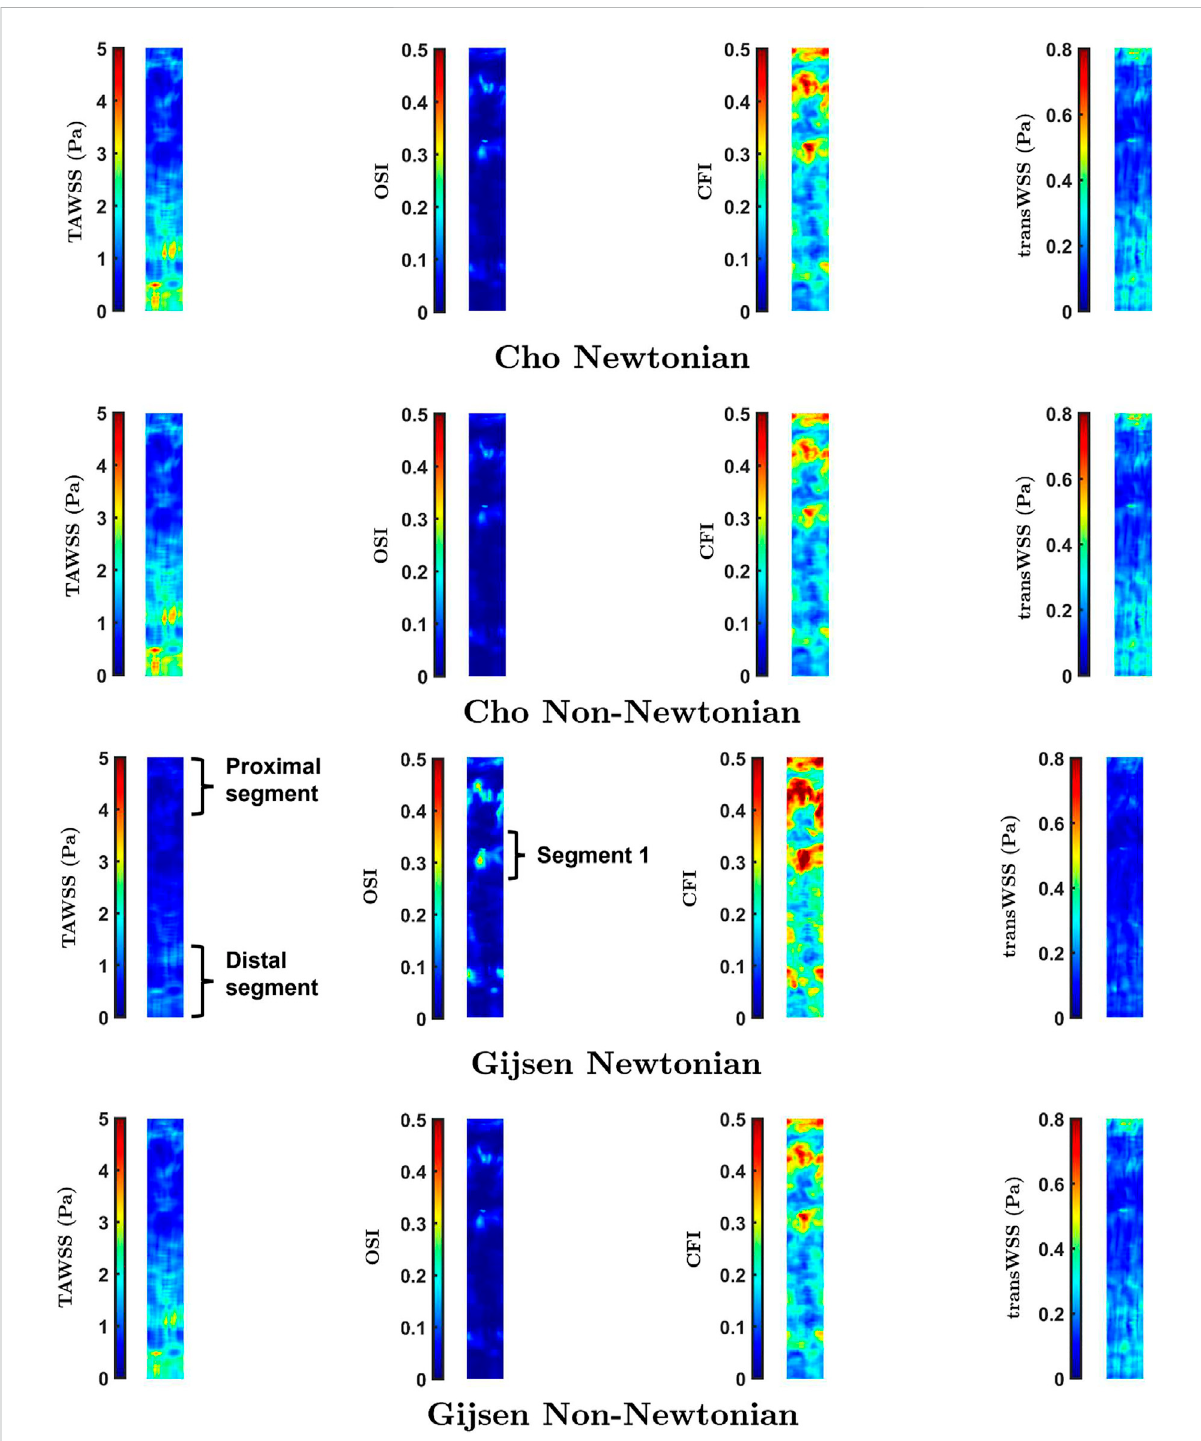
FIGURE 5 MapsofTAWSS,OSI,CFIandtransWSSintheDynamicPulsatilecaseforNewtonianandnon-NewtonianrheologyusingthemodelsofChoand Kensey (Cho and Kensey, 1991), and Gijsen et al. (Gijsen et al.,